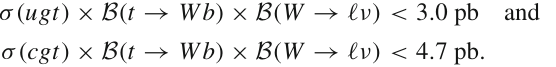
Table 4 Impact of systematic uncertainties on the expected upper lim- its on the branching ratios of the FCNC decay modes B ( t → u + g ) and B ( t → c + g ) . Four scenarios are considered: (1) include only data